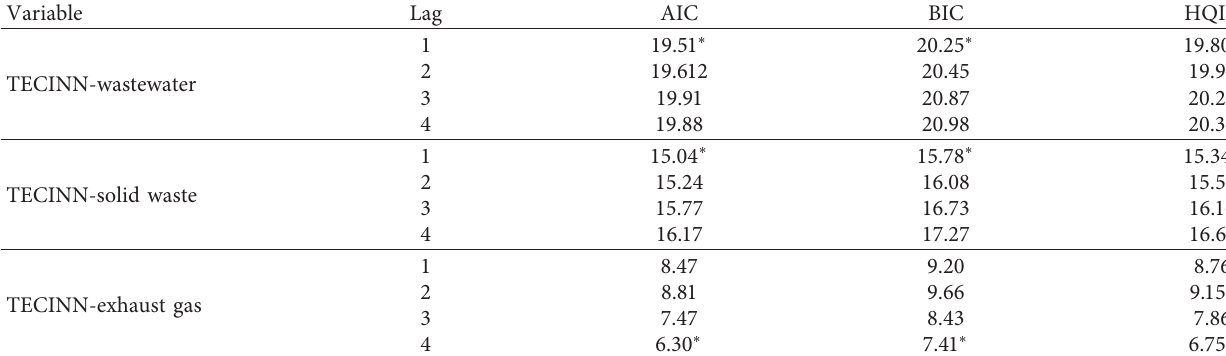
Table 4: Results of the optimal lag order test.